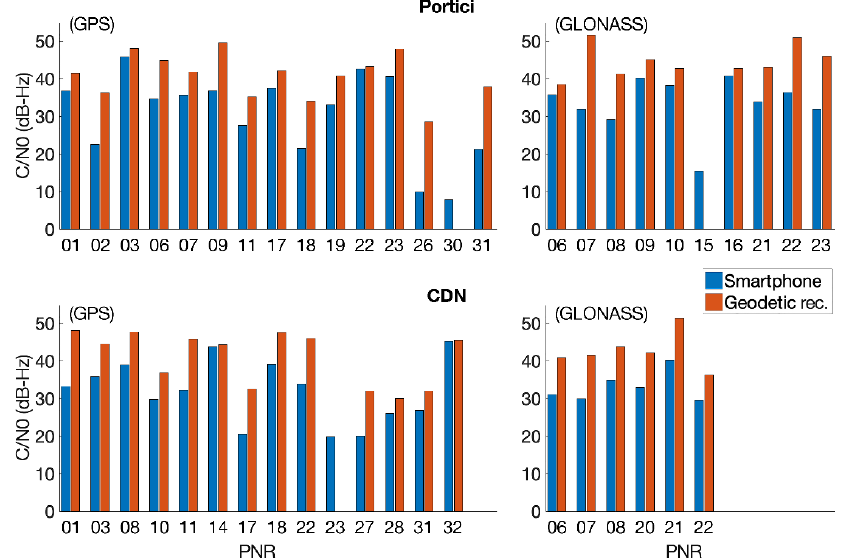
Figure 3. Mean of C/N0 values on L1 frequency comparison between smartphone and geodetic receiver. Blue bars represent smartphone, red represent geodetic receiver: top rows depict mean of C/N0 for GPS and Galileo satellites in Portici site; bottom rows depict mean of C/N0 for GPS and Galileo satellites in CDN site.